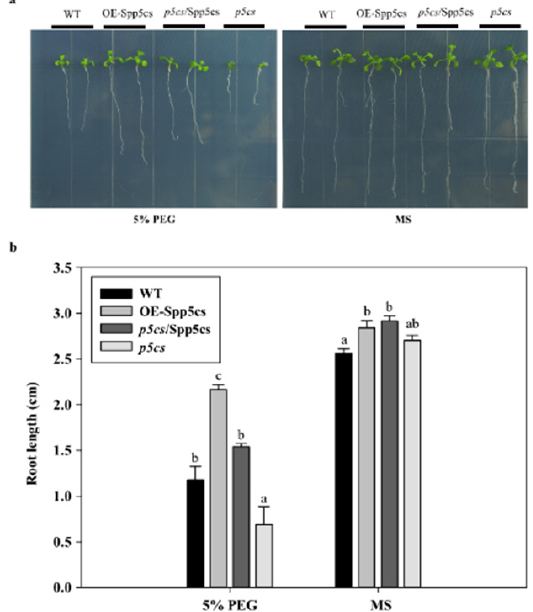
Figure 4. Root length analysis of WT, OE-SpP5CS, p5cs /SpP5CS-complemented and p5cs mutant A. thaliana seedlings in response to drought stress. ( a ) Growth of plants under drought stress conditions. Seeds were grown on the 1/2 MS medium and 1/2 MS medium supplemented with 5% PEG 6000 for 10 d; ( b ) Root lengths of WT, OE-SpP5CS, p5cs/SpP5CS -complemented and p5cs mutant plants grown under normal and drought stress conditions. Data were obtained from three independent experiments. Each column represents the mean ± SD, and the error bar denotes the standard deviation. Different letters indicate significant differences in the root length (one way ANOVA, Tukey’s test, p < 0.05).